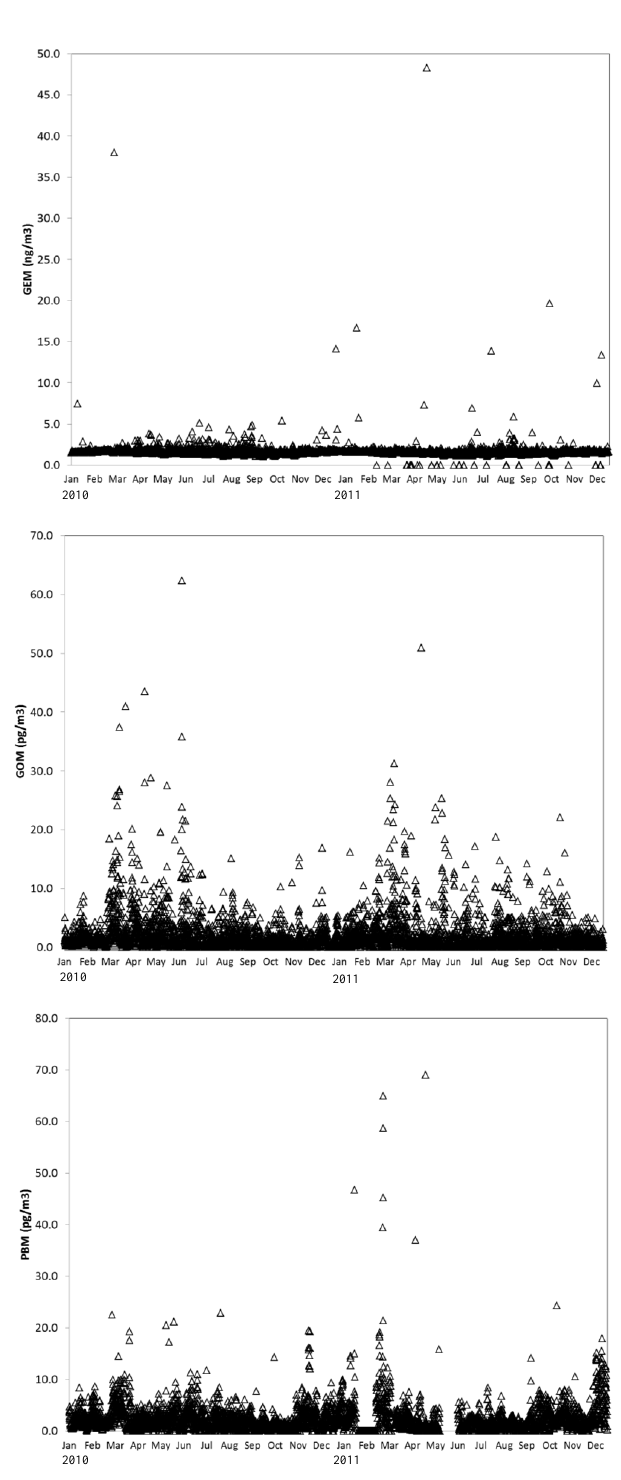
Table 2. Seasonal GEM (ngm − 3 ) , GOM (pgm − 3 ) , and PBM (pgm − 3 ) concentrations at Dartmouth (mean ± standard